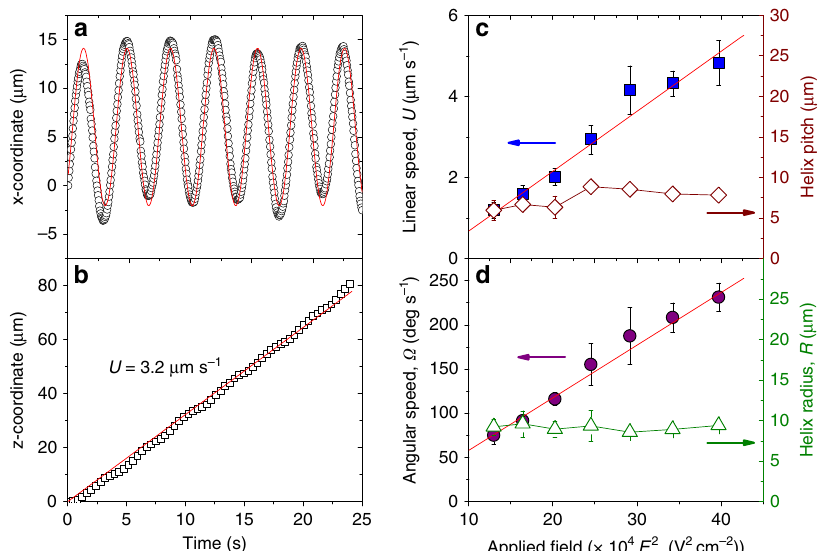
Fig. 2 Characterization of the helical trajectory of patchy particles in electric fi eld. a , b x- and z- location of a metallodielectric particle self-propelling along a helical path in electric fi eld (250 V cm − 1 and 10 kHz). The scattered points represent the experimental data, and lines are fi t using equation (1). The data- fi tting provides the angular speed, helix radius, and linear speed in the z -direction. c , d Increase in the linear and angular speed of the particle performing helical motion with increasing strength of the applied electric fi eld. The velocities scale linearly with E 2 , which agrees with predictions based on ICEP. The pitch and radius of the helical trajectory are independent of the fi eld strength. The data are obtained on one speci fi c particle of radius 1.4 µ m with metal patch fabricated using deposition angle φ = 10°. The error bars in c and d are standard deviation of the corresponding data set of at least ten helical rotations